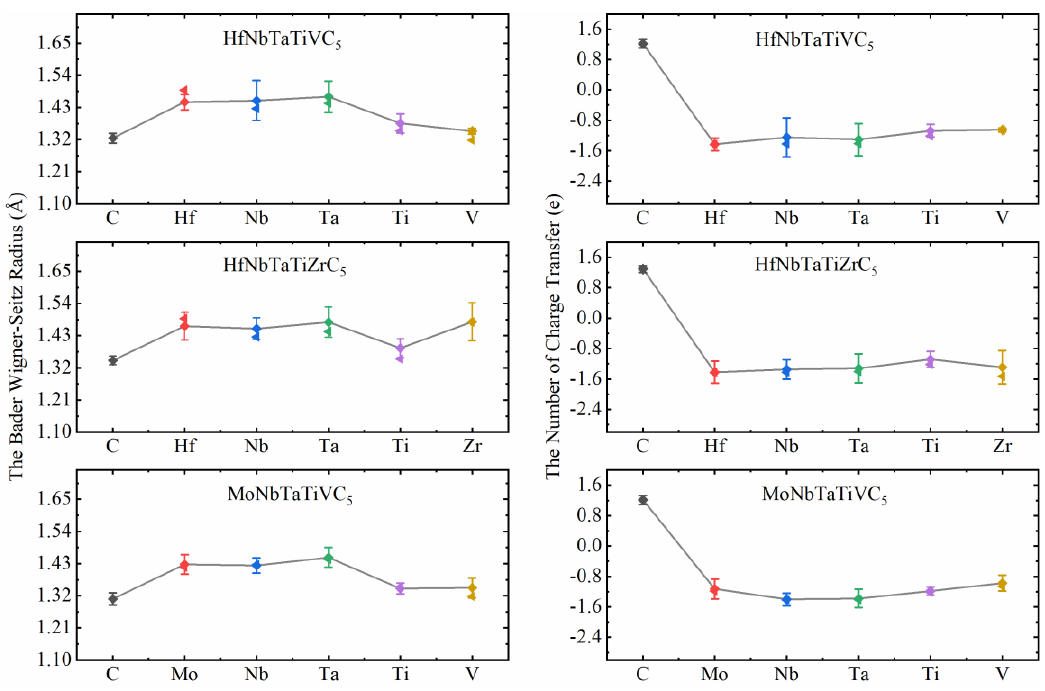
Figure 3. Shown are the Bader WS radius and the Bader charge transfer of individual alloy components.